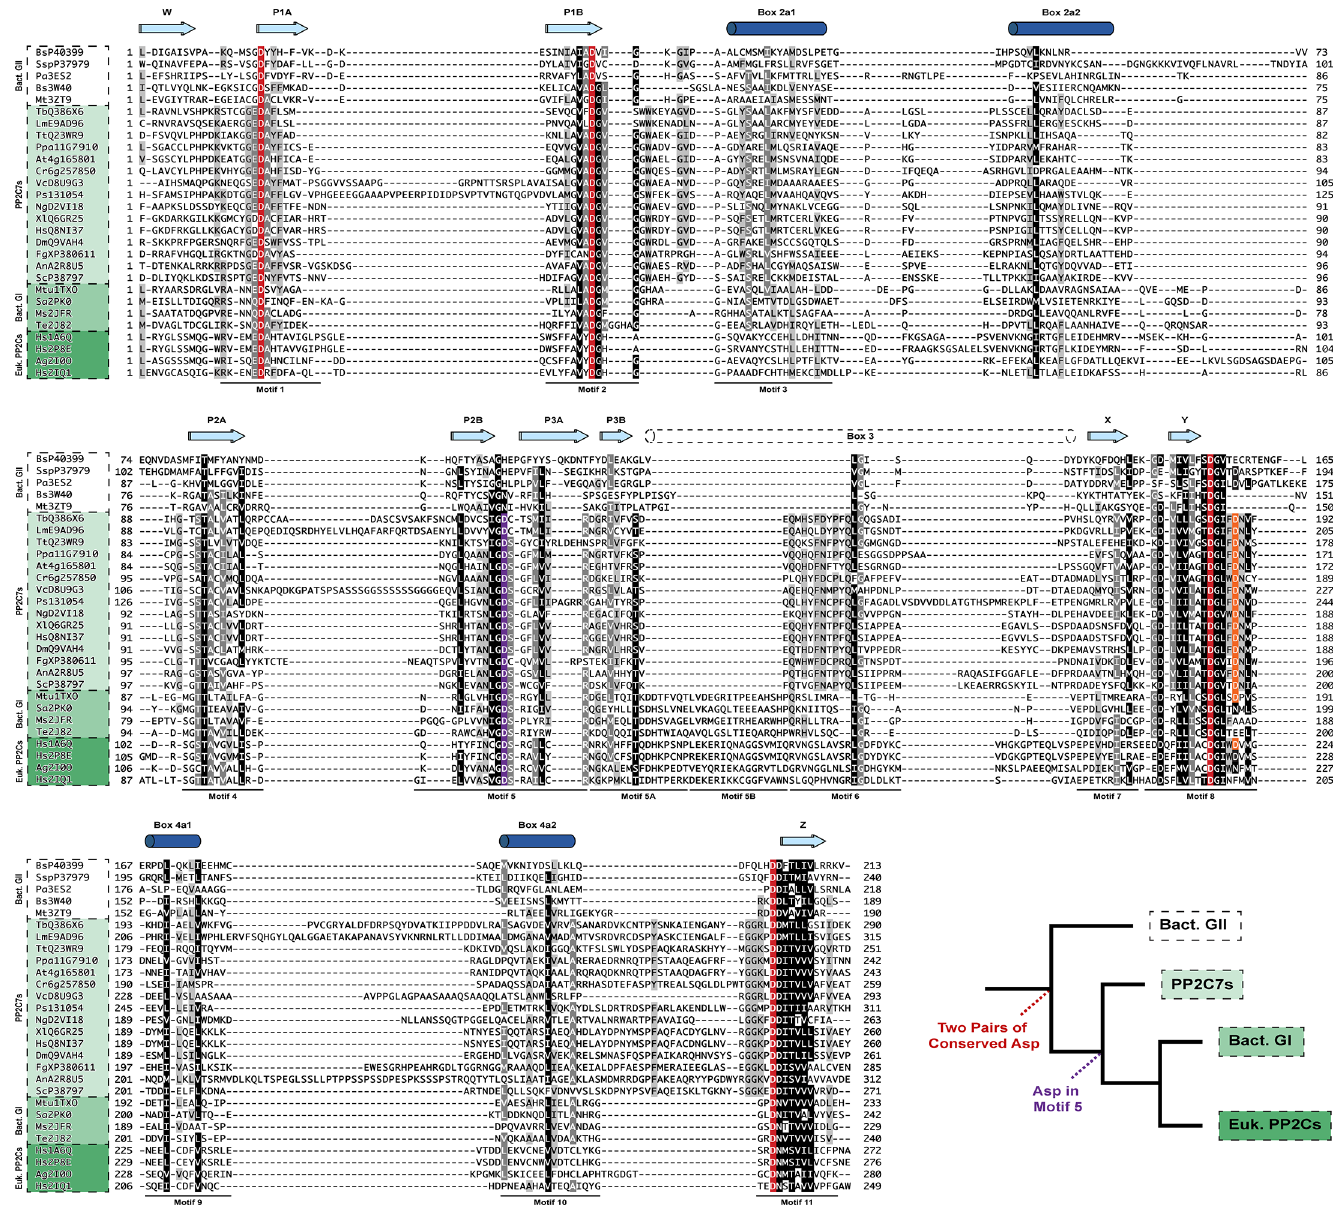
Fig 7. Structure-guided alignment of bacterial Group II, PP2C7, bacterial Group I, and eukaryotic PP2C sequences. Information from solved structures of bacterial Group II, bacterial Group I, and eukaryotic PP2Cs (indicated by their four-character PDB codes) was used to guide this alignment, as detailed in “ Materials and Methods ” . Above the sequences are shown conserved beta-strand and α -helical secondary structure elements. “ Box ” refers to a more variable region in multiple solved structures. For a secondary structure diagram, including element numbering, see Fig F in S2 File. Sequence motifs are as given in [84]. Universally conserved aspartates involved in metal coordination are given in red. Aspartates conserved in some but not all sequences are given in purple and orange (see text for discussion). The inset shows a simplified phylogenetic tree, with the proposed evolutionary advent of critical aspartate residues indicated. See Table A in S1 File for a listing of PP2C7 sequences. Bacterial Group II sequences without solved structures are from UniProt. Species for sequences are as follows: Bs (Bacillus subtilis); Ssp (Synechocystis sp.); Pa (Pseudomonas aeruginosa); Mt (Moorella thermoacetica); Tb (Trypanosoma brucei); Lm (Leishmania major); Tt (Tetrahymena thermophila); Ppa (Physcomitrella patens); At (Arabidopsis thaliana); Cr (Chlamydomonas reinhardtii); Vc (Volvox carteri); Ps (Phytophthora sojae); Ng (Naegleria gruberi); Xl (Xenopus laevis); Hs (Homo sapiens); Dm (Drosophila melanogaster); Fg (Fusarium graminearum); An (Aspergillus niger); Sc (Saccharomyces cerevisiae); Mtu (Mycobacterium tuberculosis); Sa (Streptococcus agalactiae); Ms (Mycobacterium smegmatis); Te (Thermosynechococcus elongatus); Ag (Anopheles gambiae).